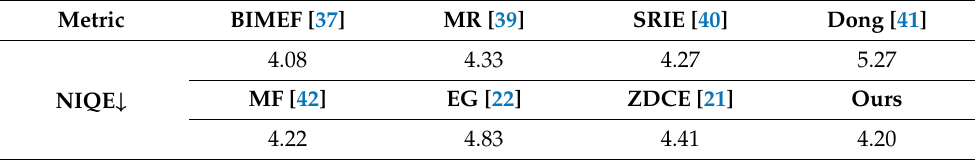
Table 2. Quantitative results in the MUED dataset: MR (MultiscaleRetinex), EG (EnlightenGAN), and ZDCE